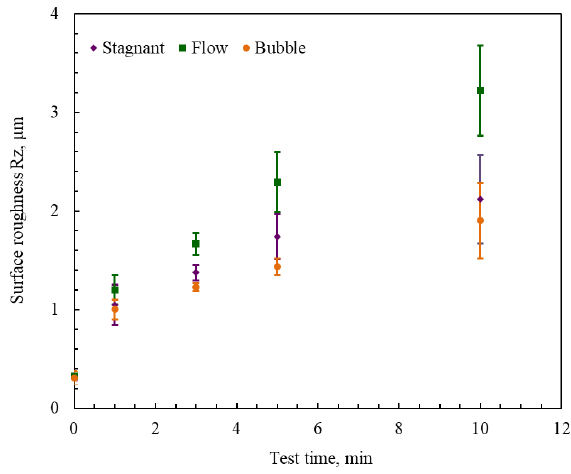
Figure 7. Change in the surface roughness R Z as a function of the exposure time in different working conditions.